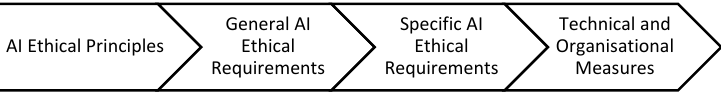
Figure 1. Steps for operationalizing AI ethical principles.